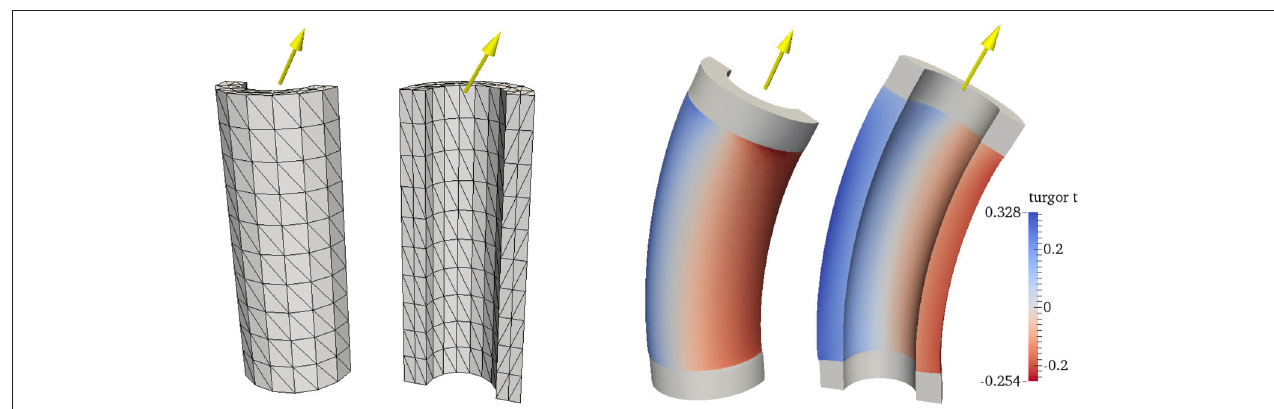
FIGURE 2 | Left: Front and back view of a triangulation (on mesh level L = 0 ) of half of the hollow stem. The yellow arrow represents the desired direction s des , which points toward the sun. Right: The solution of the optimal control problem. The inner pressure t is illustrated in the blue/red scale and the deformation is applied to the